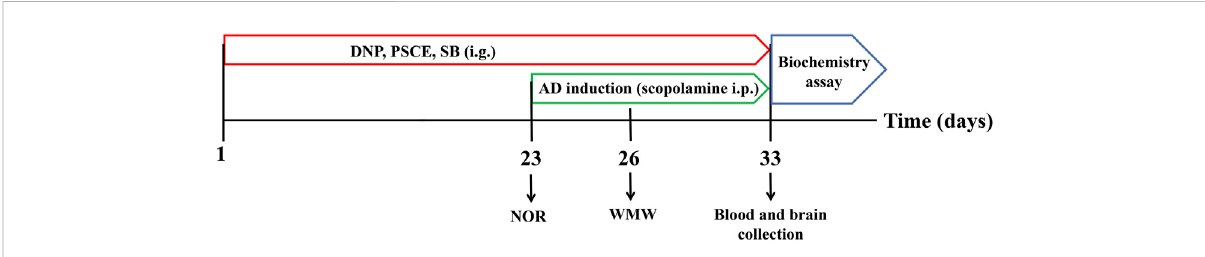
FIGURE 1 Schematic diagram of the experimental and treatment designs of